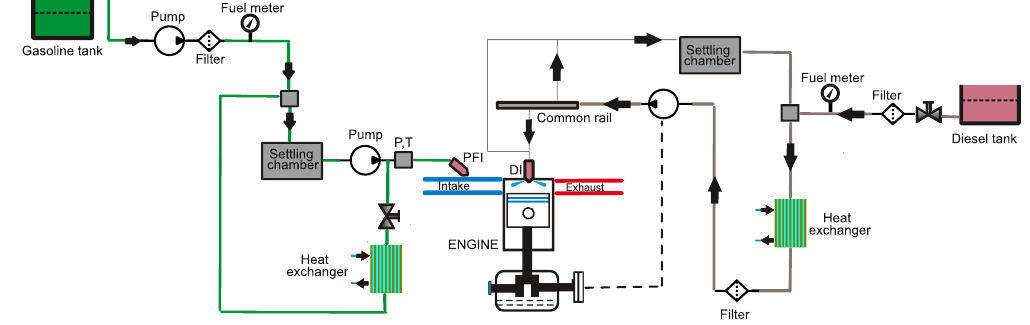
Figure 1. Fuel injection systems scheme [43]. PFI: port fuel injection; DI: direct injector. Table 2. Diesel and gasoline fuel injector characteristics.